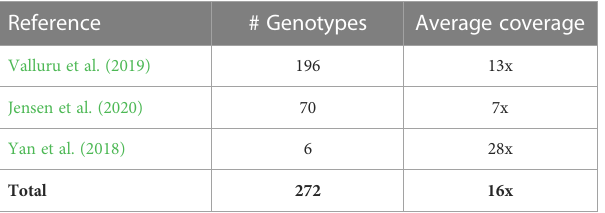
TABLE 1 A summary of publicly available data used in the current